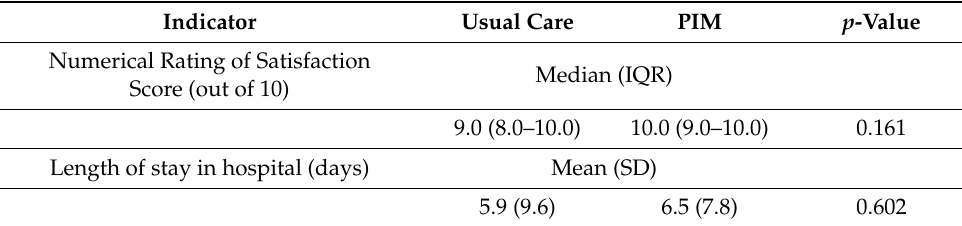
Table 5. Secondary outcomes: Satisfaction, hospital length of